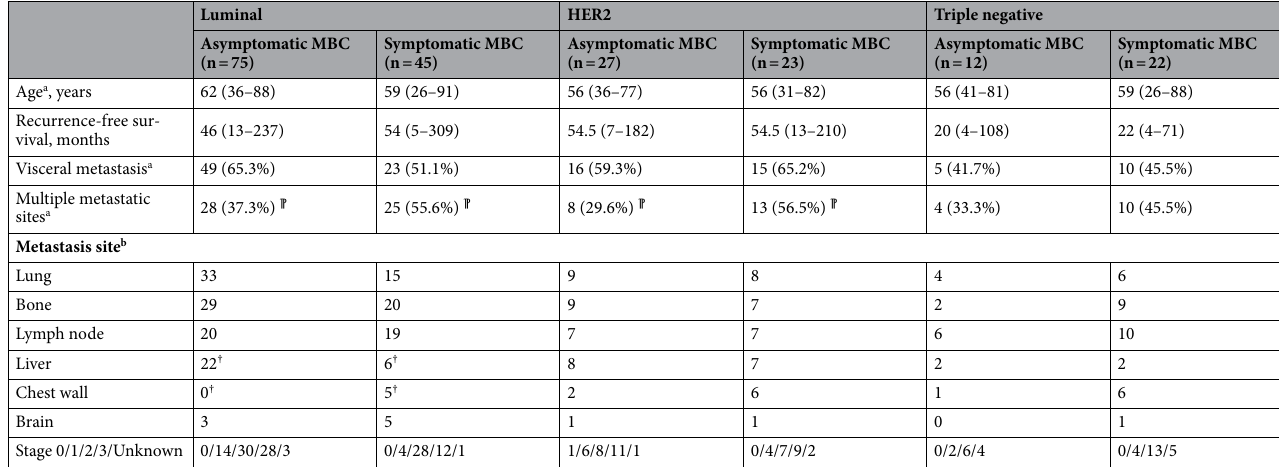
Table 2. Comparison of clinicopathological factors between the asymptomatic and symptomatic groups according to subtype. HER2 human epidermal growth factor receptor 2, MBC metastatic breast cancer, OS overall survival, PRS post-recurrence survival. a At the time of confirmation of metastasis. b There are duplicate cases. † p-value less than 0.05. ⁋ p-value greater than 0.05, less than 0.1.